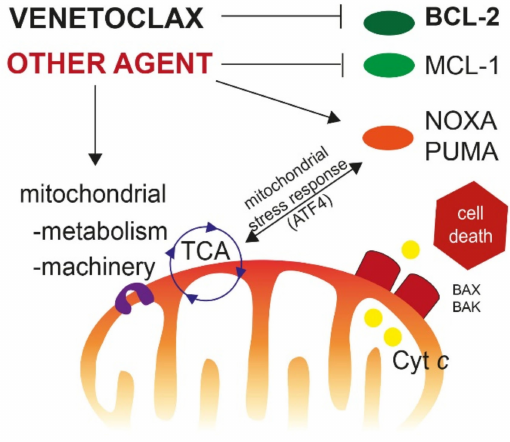
Figure 1. Main pathways for targeting venetoclax resistance. New therapeutic agents can inhibit other antiapoptotic proteins such as MCL-1 or increase the expression of proapoptotic BH-3 only proteins (NOXA, PUMA), in order to release cytochrome c, leading to apoptotic cell death. Targeting mitochondrial metabolism (i.e., OxPhos) or mitochondrial machinery (electronic transport chain, mi- tochondrial DNA replication, mitochondrial translation, mitochondrial structure, etc.) may increase the efficacy of BH-3 mimetics, by inducing the mitochondrial integrative stress response driven by the transcription factor ATF4. Abbreviation: TCA, tricarboxylic acid cycle. Cyt c : cytochrome c